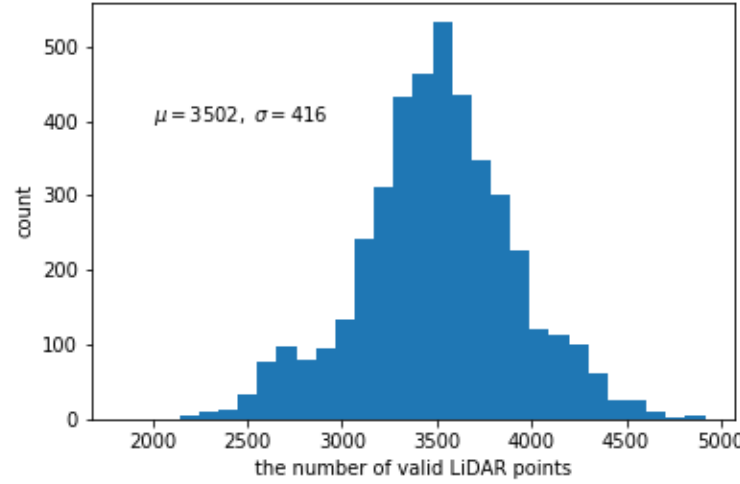
Figure 6. Histogram of the number of valid LiDAR points in 2D lidar reflection-intensity